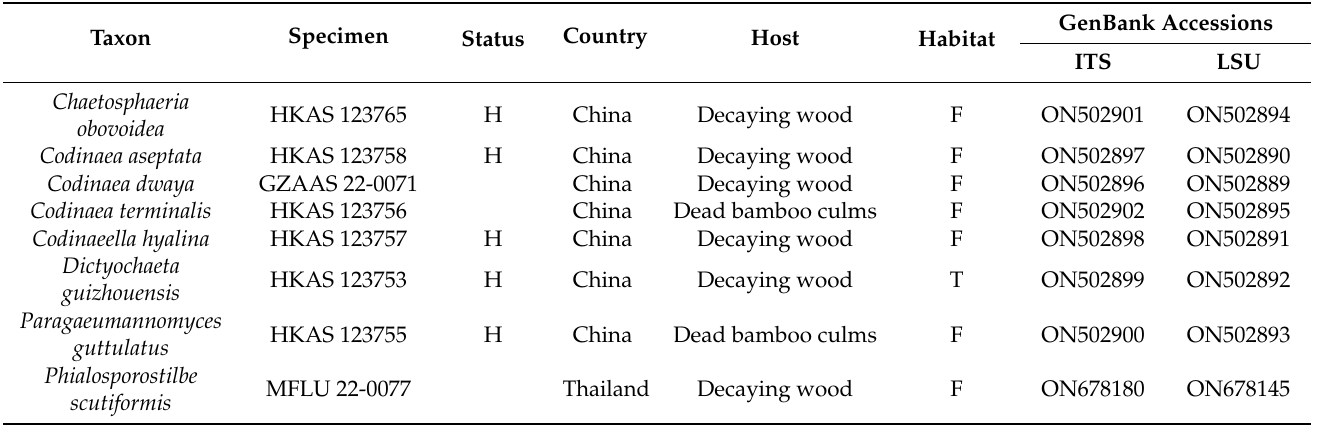
Table 1. Taxa, isolate information and GenBank accession numbers for new collections determined for this